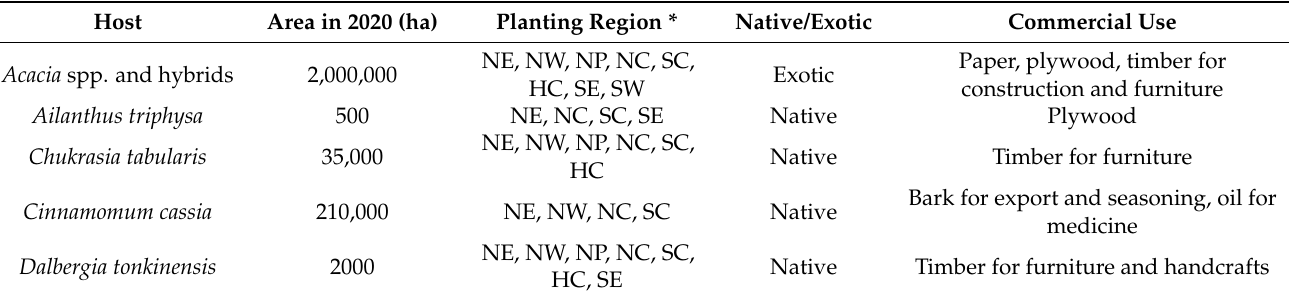
Figure 1. Map of Vietnam showing the eight forest geographic regions. Table 1. Details of forest plantation species that were surveyed for pests and pathogens.